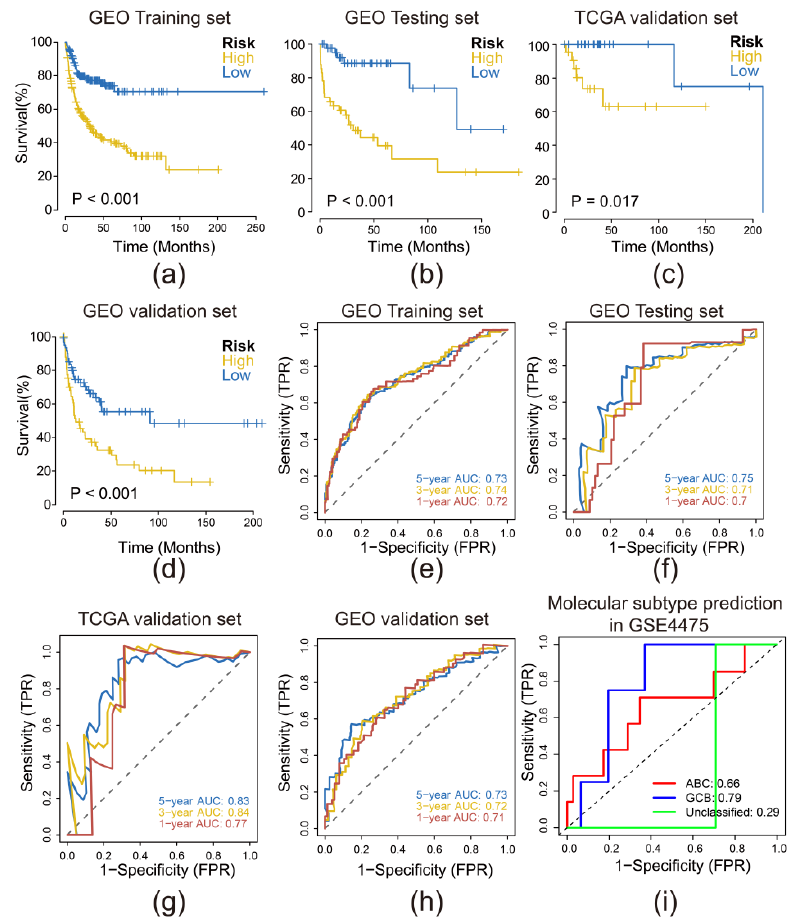
Figure 3. Risk model performed sensitively and robust in Internal and external validation